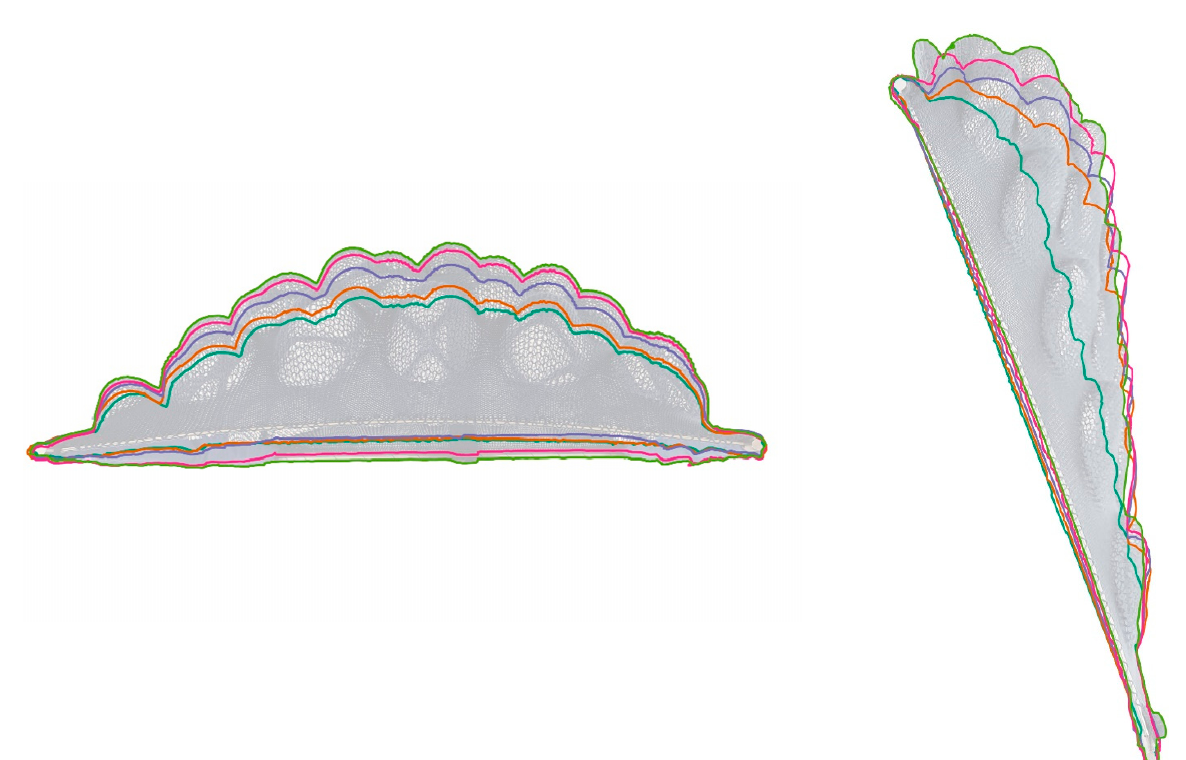
Figure 21. Estimated deformation shape of the knitted model drop-stitch 10%, based on the posi- tions of the center of the ellipses on the third row from the top at the different windspeeds from 0 to 15 m/s in photos from wind-tunnel tests. The values represent distances in millimeters.